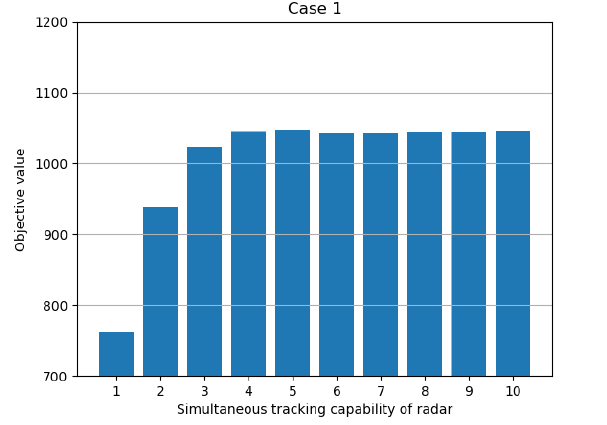
Figure 8. Objective value with respect to number of simultaneous tracking